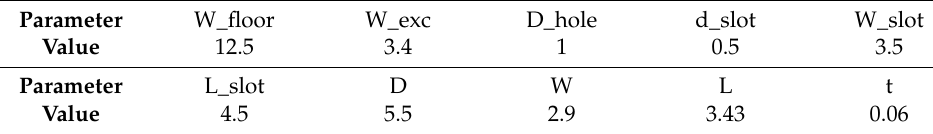
Table 1. Optimized geometrical parameters (unit: mm).